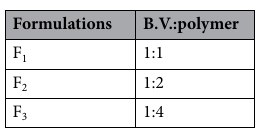
Table 1. Composition of different B.V. loaded cross-linked chitosan